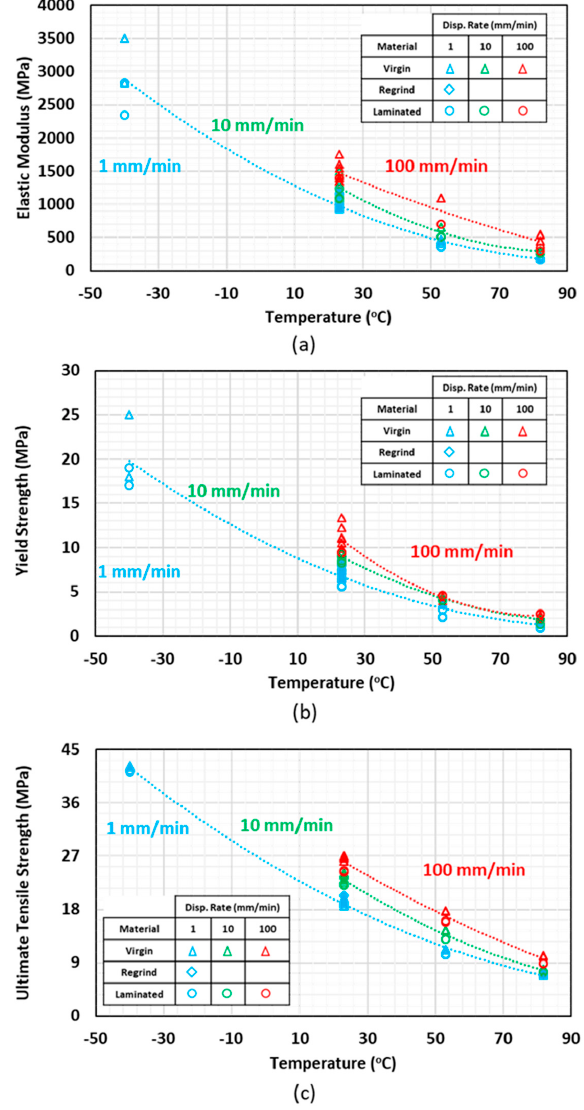
Figure 4. ( a ) Elastic modulus, ( b ) yield strength, and ( c ) ultimate tensile strength variations with ff erent strain temperature at three different strain rates. temperature at three di